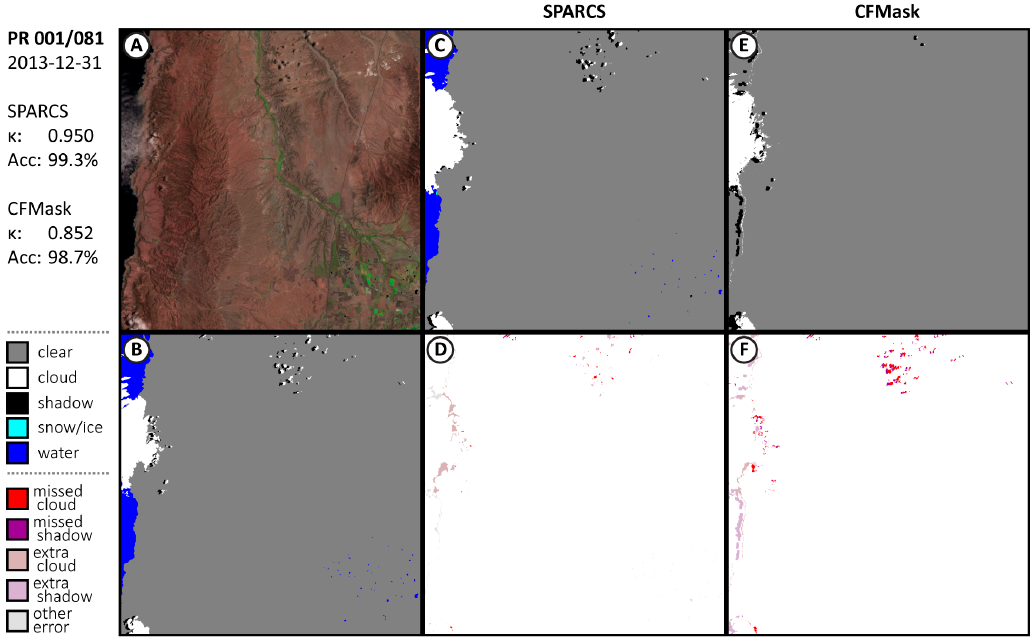
FigureA1. ResultsforvalidationtestimagePR001 / 081, withfalsecolorimageusedduringinterpretation ( A ), the manually labeled interpretation ( B ), generated masks from SPARCS ( C ) and CFMask ( E ), and respective spatial distribution of errors ( D , F